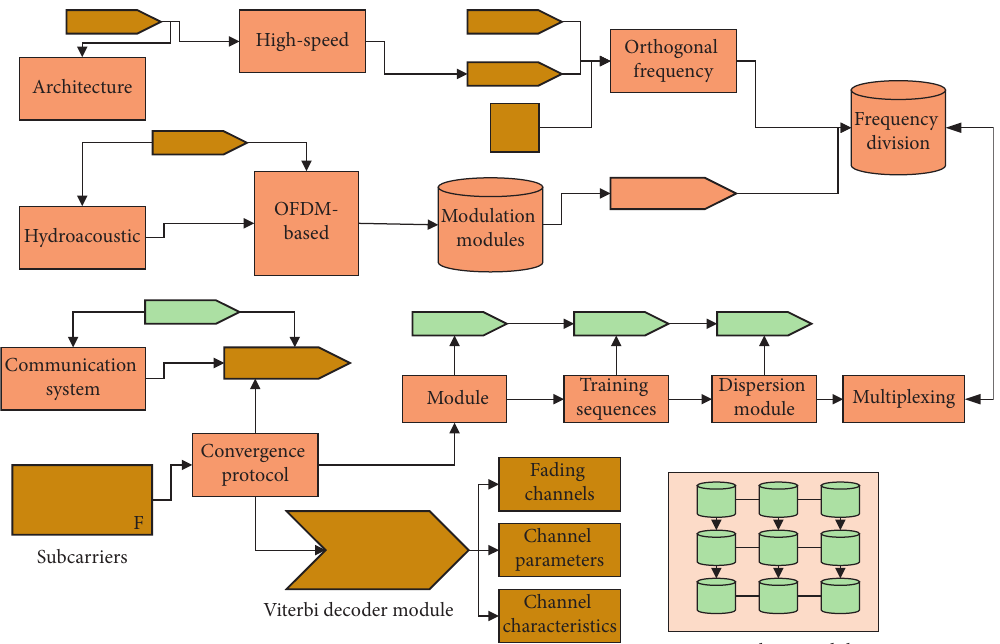
Figure 1: Structure of high-speed hydroacoustic OFDM-based communication system.